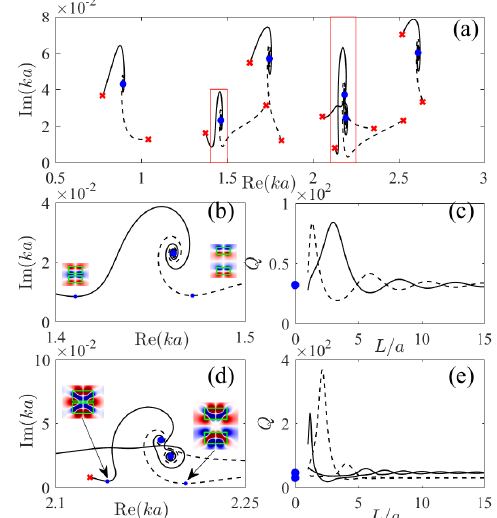
Figure 14: (a) Behavior of resonant eigenfrequencies under variation of the distance between the disks L with ϵ = 12 (silicon in optical range) and aspect ratio a/h = 1 . (b) zoomed area highlighted in (a) with symmetric (solid lines) and antisymmetric (dash lines) hybridization (20) of reso- nant modes of the isolated disk. (c) shows behavior of the Q factor vs the distance for corresponding insets at the left. Closed circles mark the eigenfrequencies of isolated disks and respectively the Q factors while crosses mark the lim- iting case L = a when two disks stick